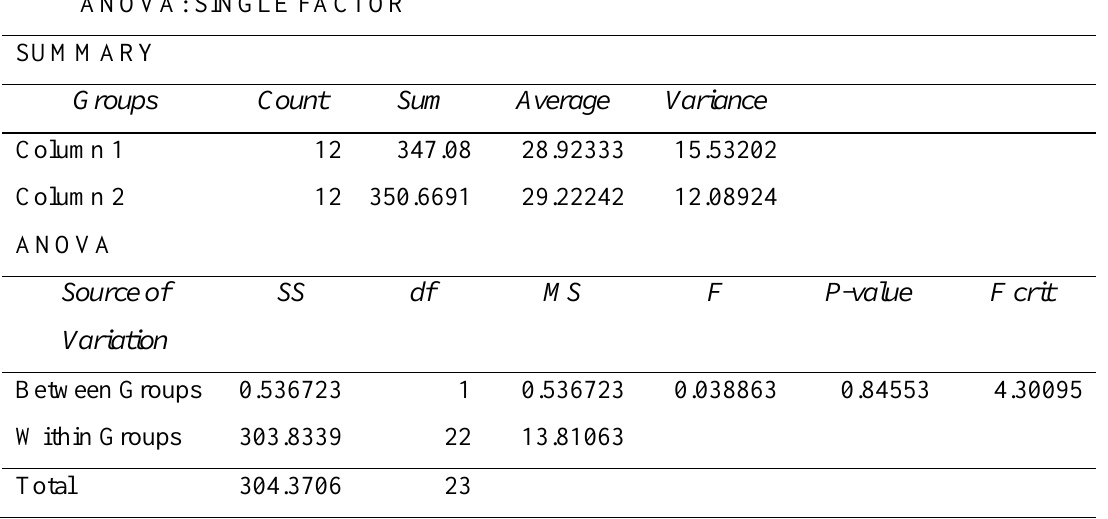
ANOVA Analysis for Mahogany.